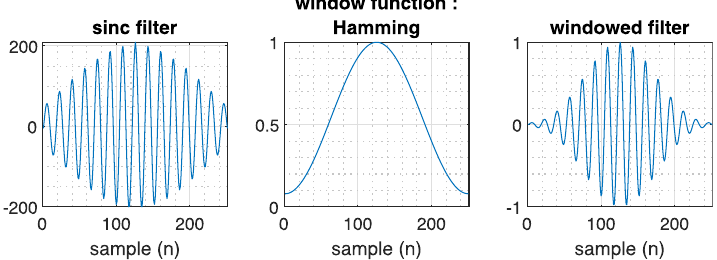
Fig. 1 Windowing effect on the ideal Sinc filter